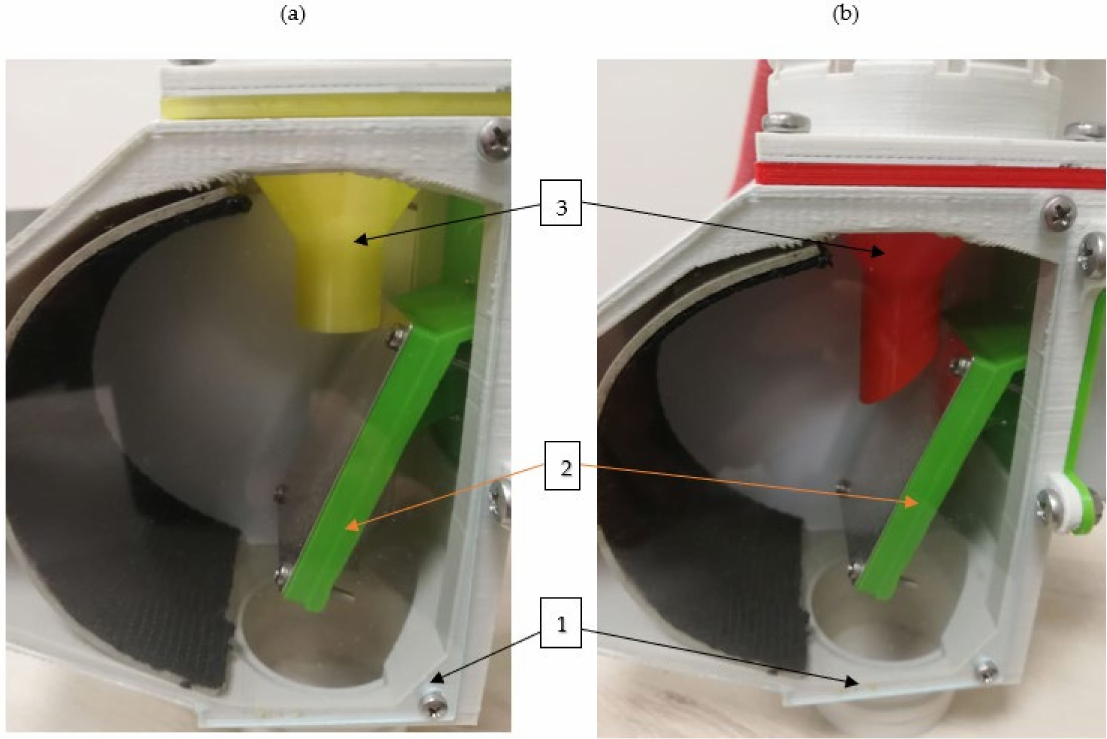
Figure 6. Tested configurations of the exit hole: ( a ) straight system, ( b ) diagonal system: 1—sensor housing, 2—piezoelectric sensor, 3—exit